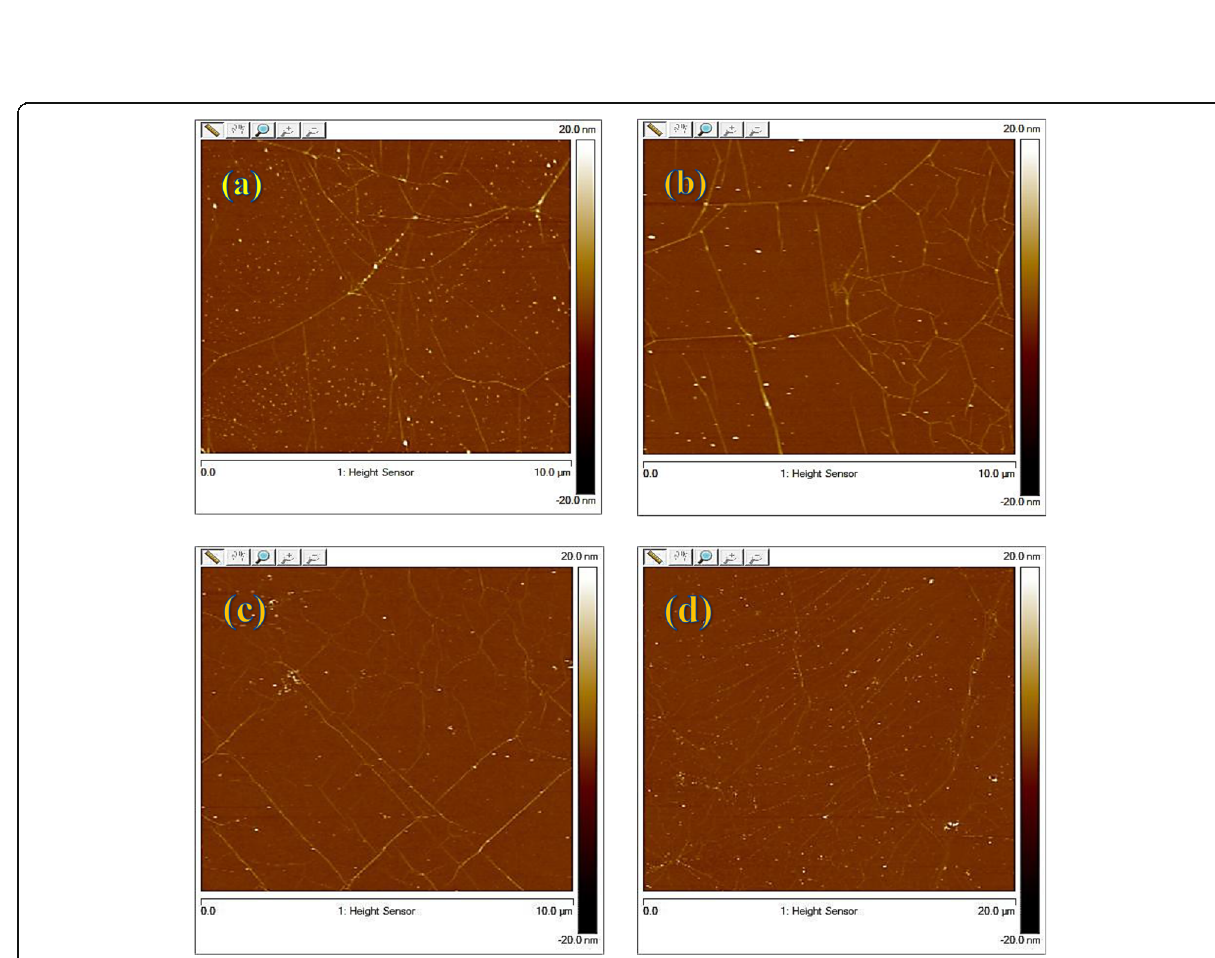
Fig. 3 AFM spectrum of a rosin/graphene coated transfer at room temperature (RMS = 0.668nm) and b – d rosin/graphene sample baked at 100 °C (RMS = 0.889 nm), 150 °C (RMS = 0.97 nm), and 200 °C (RMS = 0.992 nm),